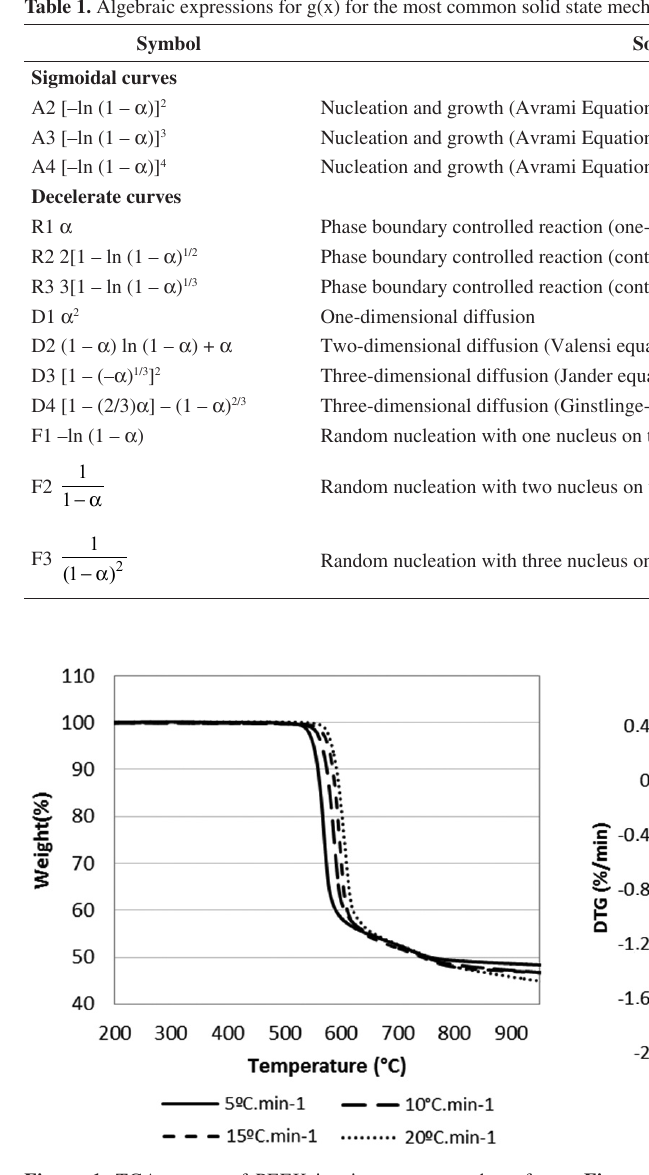
Figure 1. TGA curves of PEEK in nitrogen atmosphere for the heating rates of 5 °C.min –1 ; 10 °C.min –1 ; 15 °C.min –1 and 20 °C.min –1 . Table 2. Thermal characteristics of PEEK for the heating rates of 5 °C.min –1 ; 10 °C.min –1 ; 15 °C.min –1 and 20 °C.min –1 in nitrogen atmosphere. Heating rates